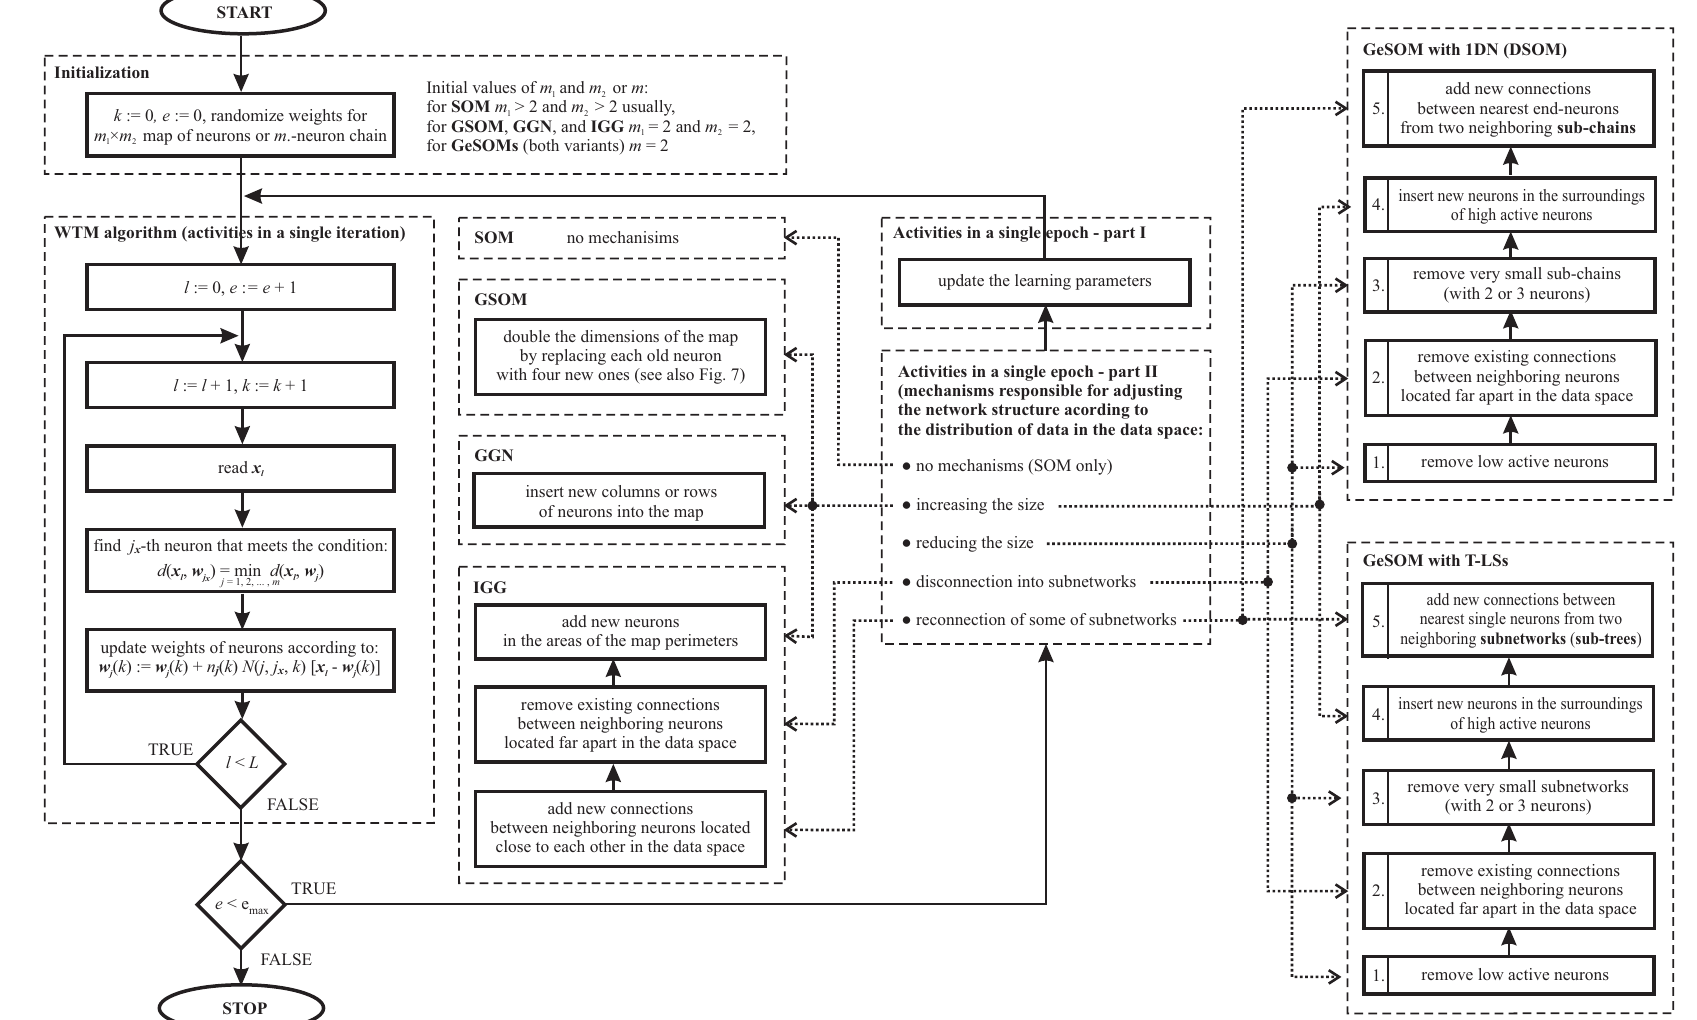
Figure 2. Block schemes of the learning algorithms of the conventional SOM, GSOM, GGN, IGG, GeSOM with 1DN (DSOM), and GeSOM with